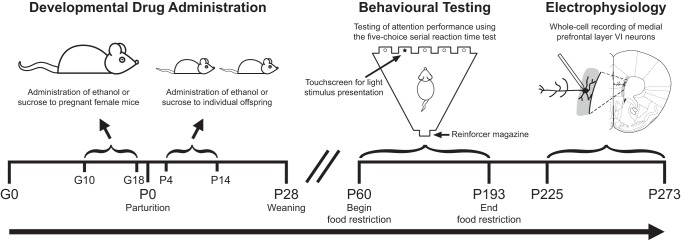
Schematic illustration of the study design. Timed-pregnant female mice were administered either ethanol or an isocaloric/isovolumetric amount of sucrose by gavage from G10 to G18. Offspring were then administered the same treatment (ethanol or sucrose) by gavage from P4 to P14. Male offspring were food-restricted and tested for attention behavior using the 5-CSRTT from P60 to P193 (the age of the oldest mouse to complete testing). The same cohort of male offspring was then tested for electrophysiological function of medial prefrontal layer VI pyramidal neurons between P225 and P273. The coronal slice diagram was modified from Paxinos and Franklin, 2001. Timelines are not drawn to scale.